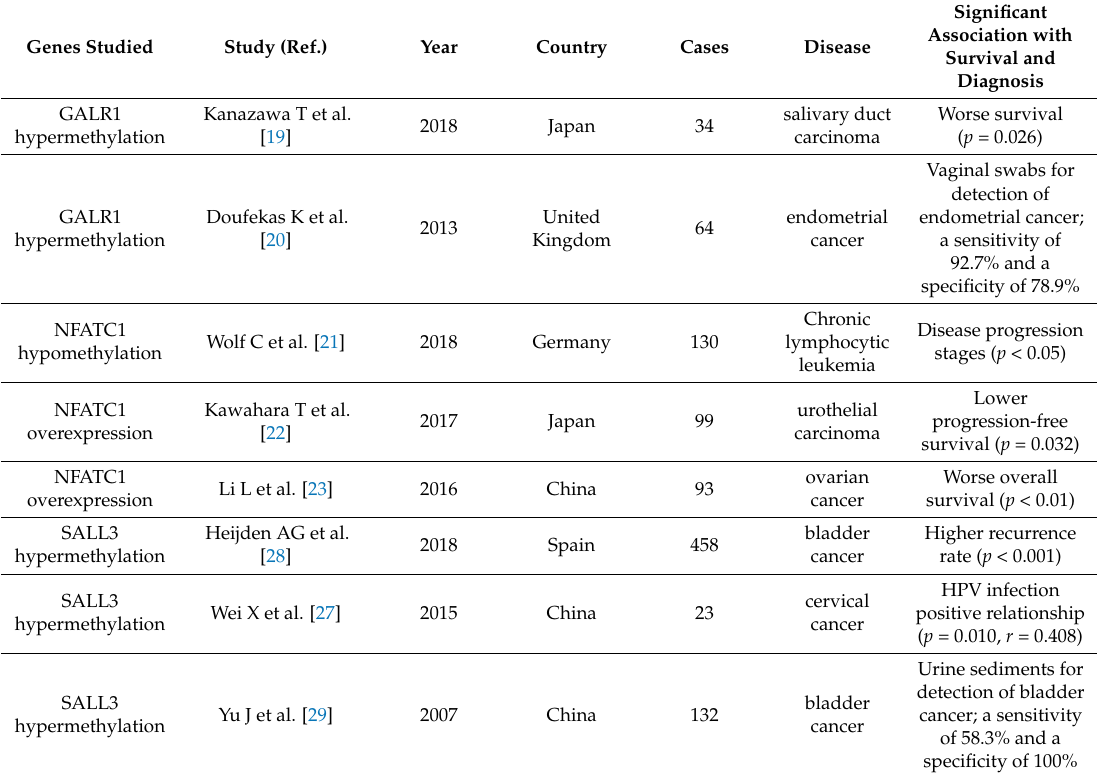
Table 4. Published studies of 18q23 genes and biomarkers for